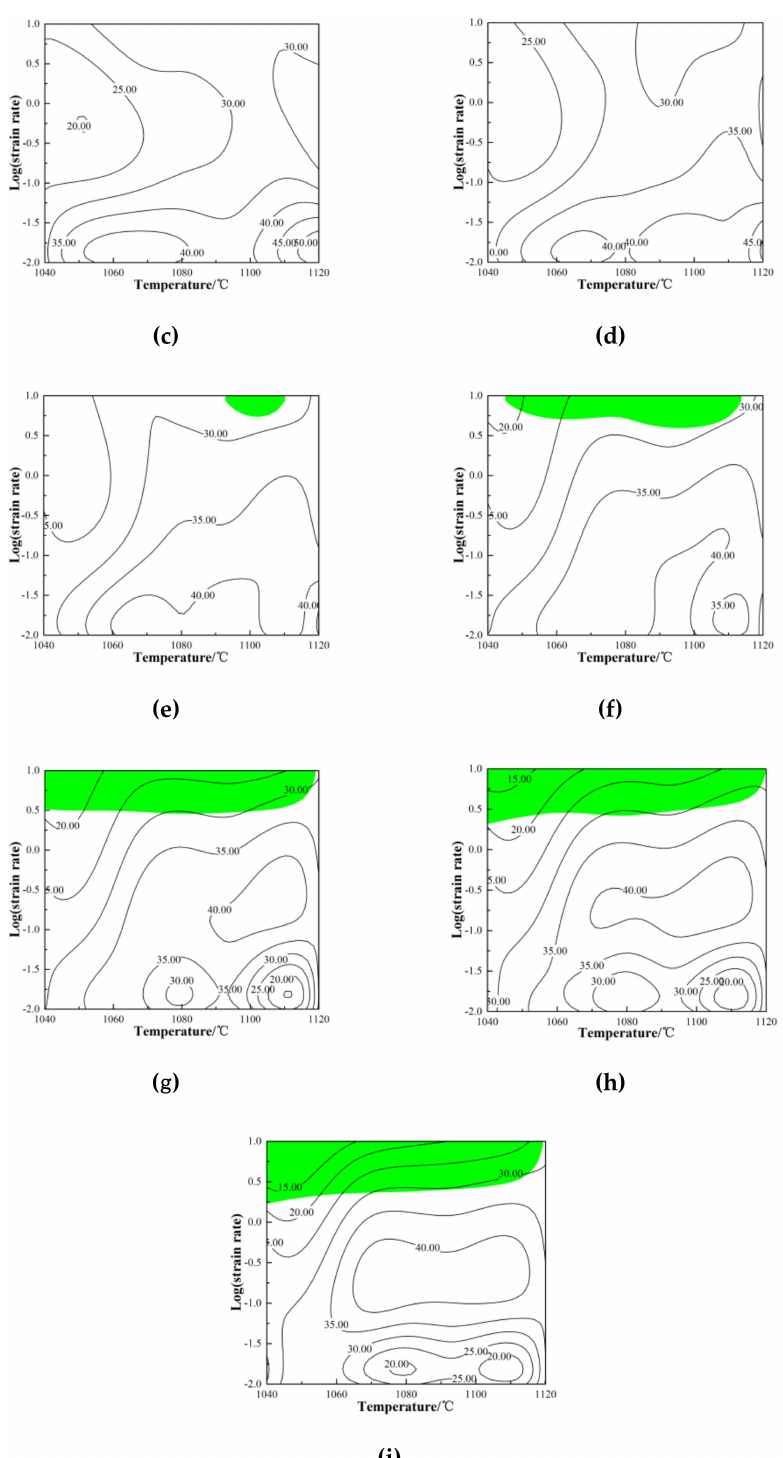
Figure 9. The processing map of flow instabilities under strains of 0.1~0.9. ( a ) ε = 0.1; ( b ) ε = 0.2; ( c ) ε = 0.3; ( d ) ε = 0.4; ( e ) ε = 0.5; ( f ) ε = 0.6; ( g ) ε = 0.7; ( h ) ε = 0.8; ( i ) ε =